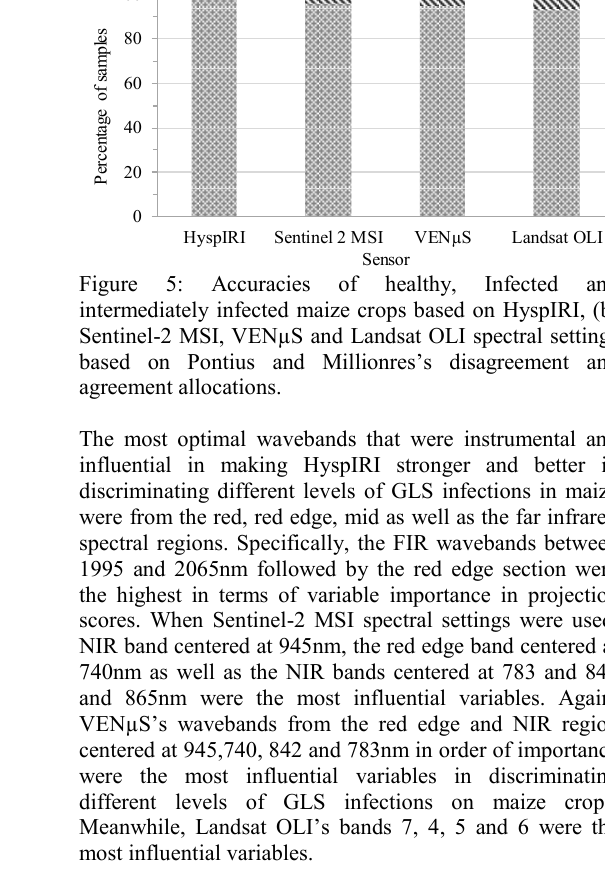
Figure 4: PLS-DA classification accuracies of healthy, Infected and intermediately infected maize crops based on (a) HyspIRI, (b) Sentinel-2 MSI, (c) VENμS and (d) Landsat OLI spectral settings.